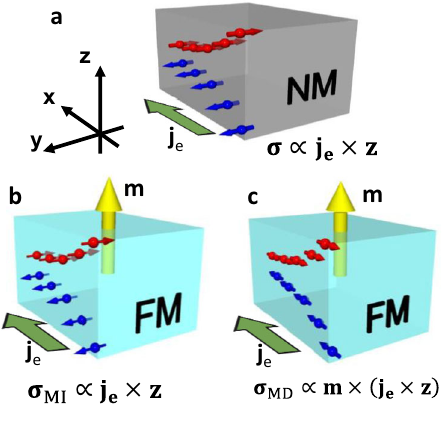
Fig. 1 Charge-to-spin conversion in NMs and FMs. a Charge current- induced spin current in NMs. σ is de fi ned as spin polarization of the generated spin current. Green arrow shows the direction of charge current j e . b , c Charge current-induced spin current in FMs. Yellow arrow shows magnetization of FM ( m ). Two spin currents with different spin polarization can be generated: b σ MI and c σ MD